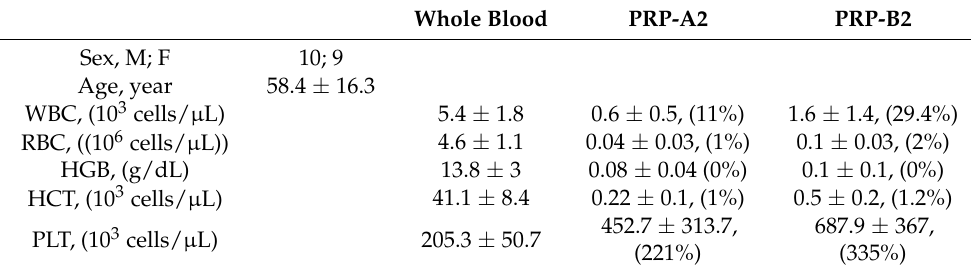
Table 2. The correlation between the concentration of TGF- β 1 and PDGF-AB in different time points and culture devices.